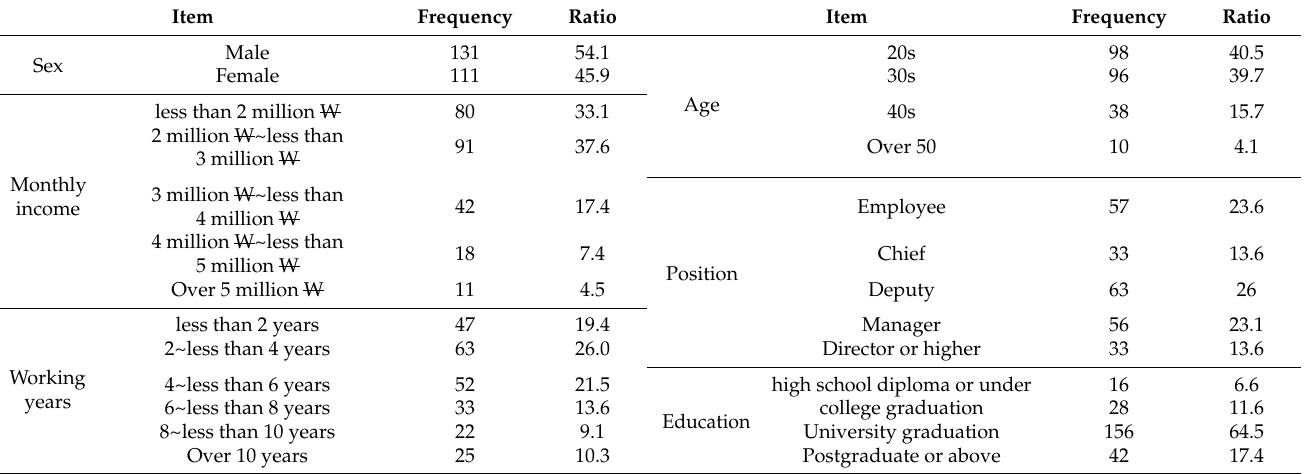
Table 1. Profile of